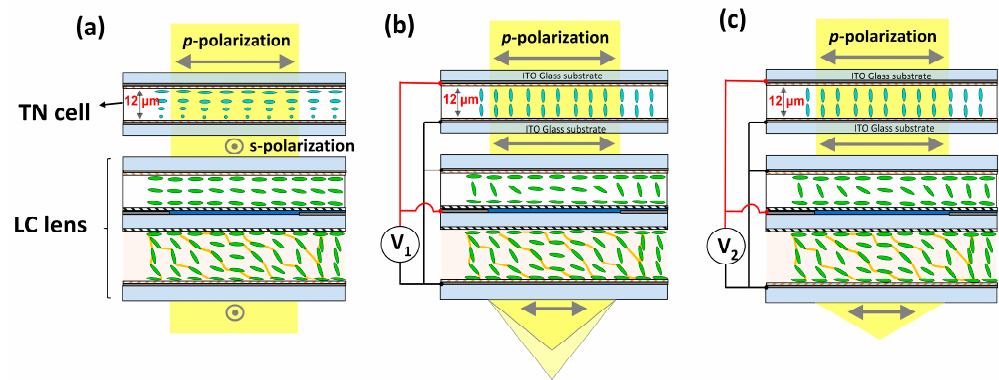
Figure 3. Scheme of the electric operation of the TCLC lens: ( a ) Lens operation in the off-state; ( b ) Lens operation in the on-state with tunable coaxial bi-focus characteristics; ( c ) Lens operation in the on-state with tunable single focus, which yields a higher focusing power and shorter focal lengths. One applied voltage of V 1 was in the range between 20 and 90 V rms and the other applied voltage of V 2 was over 90 V rms .